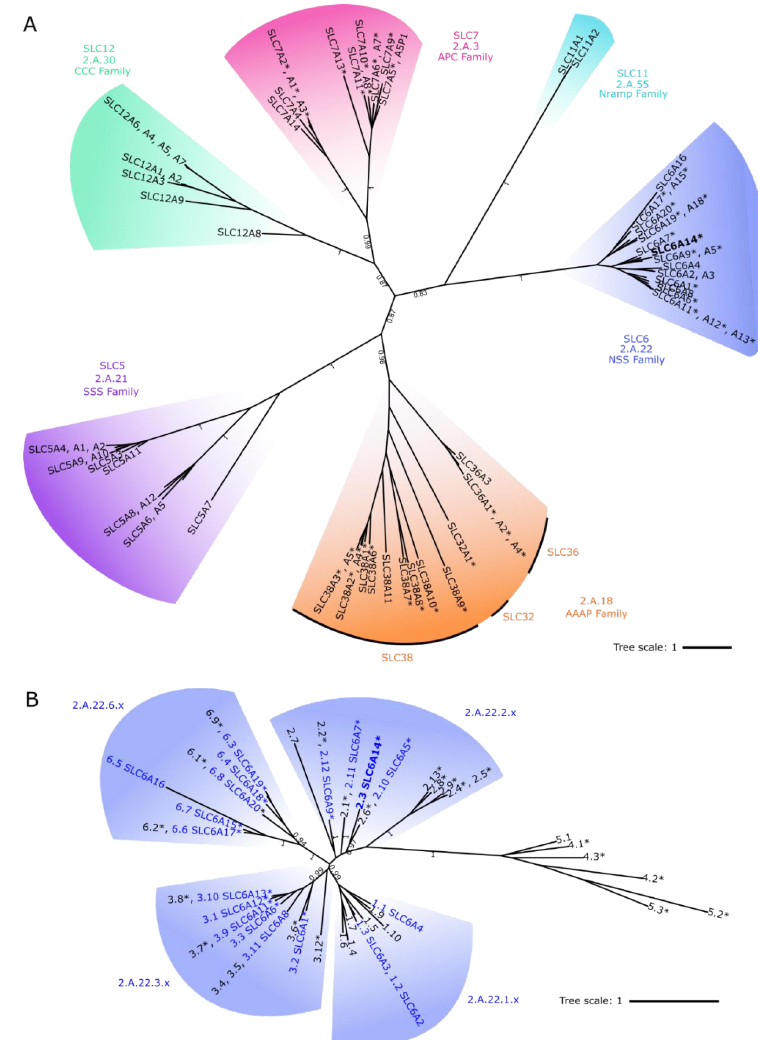
Figure 1. Amino acid transporters are found within multiple families of the APC superfamily including the Neurotransmitter:Sodium Symporter (NSS, 2.A.22) family. ( A ) Phylogenetic analysis of human APC superfamily proteins predicted to have a LeuT-fold core structural motif despite transporting many different solute types. Asterisks: proteins known to transport at least one type of amino acid. SLC families are as follows: SLC5 (in the Solute:Sodium Symporter (SSS) Family, 2.A.21), SLC6 (in the Neurotransmitter:Sodium Symporter (NSS) Family, 2.A.22), SLC7 (in the Amino Acid-Polyamine-Organocation (APC) Family, 2.A.3), SLC11 (in the Metal Ion (Mn 2+ -iron, Nramp) Transporter Family, 2.A.55), SLC12 (in the Cation-Chloride Cotransporter (CCC) Family, 2.A.30), and SLC32, SLC36, & SLC38 (in the Amino Acid/Auxin Permease (AAAP) Family, 2.A.18). The tree was inferred using Phylobayes [45] and the C60 model [46]. Where necessary, labels are grouped to prevent overlap. Branch values: posterior probabilities, indicative of the level of support, shown for key internal branches with a value > 0.8. Supplemental Figure S1A shows the full tree with all support values and labels. ( B ) Phylogenetic analysis of the NSS (2.A.22) family using eukaryote and prokaryote sequences assigned to this family on TCDB. Proteins are labelled by the end of their TCDB identifier and, for human proteins (blue text), their SLC gene name. Where necessary, labels are grouped to prevent overlap. Asterisks: proteins known to transport at least one type of amino acid. All subfamily clades include amino acid transporters except the 2.A.22.1 subfamily of monoamine transporters (SLC6A2, NET; SLC6A3, DAT; SLC6A4, SERT). The tree was inferred using Phylobayes [45] and C20 model [46]. Levels of support are shown for key internal branches with a value > 0.8. Supplemental Figure S1B shows the full tree, all support values and